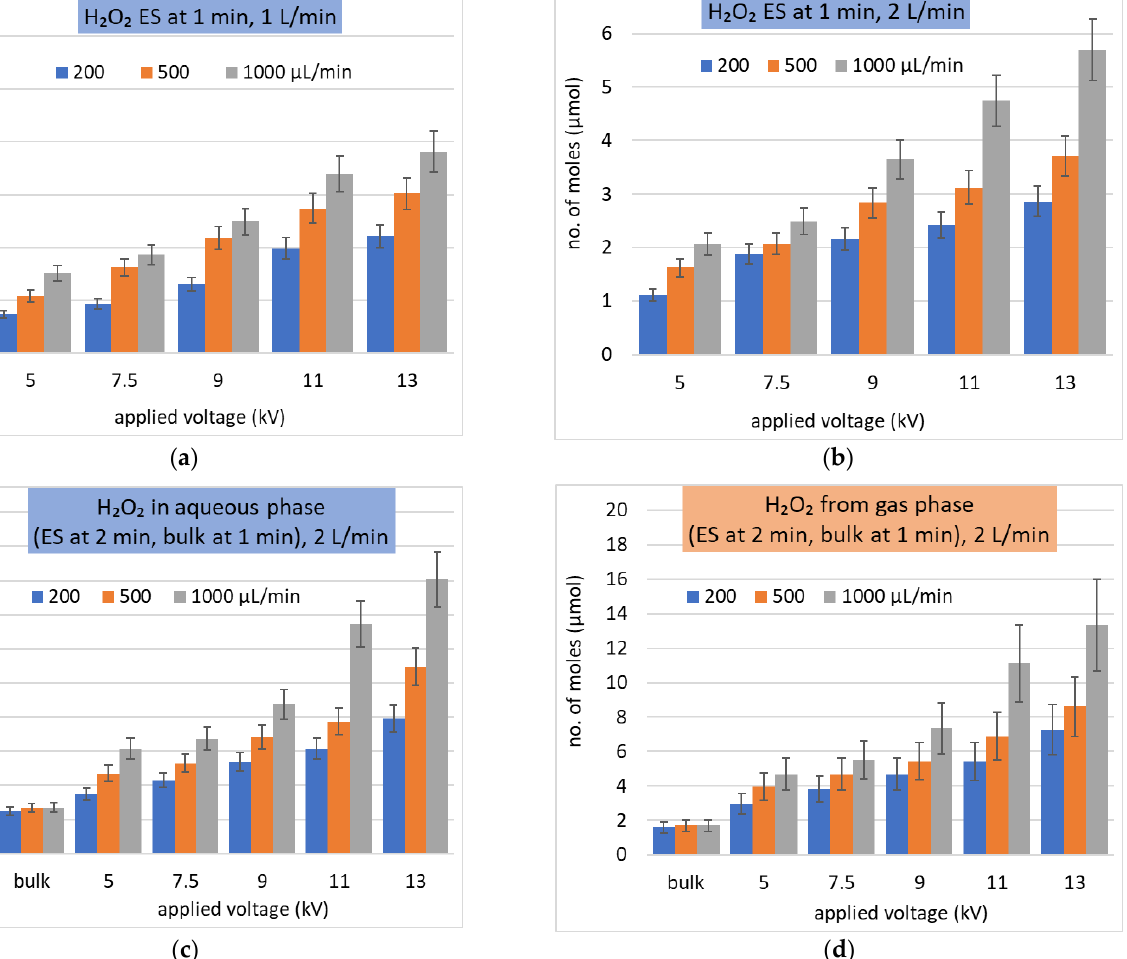
Figure 8. Solvation of H 2 O 2 as the molar number of dissolved molecules in ES. ( a , b ) different gas flow rates (L/min) and Q w (µL/min) during 1 min treatment time; ( b , c ) the same gas flow rate 2 L/min and different treatment times (min) in ES and in ( c ) also bulk water added; ( d ) depleted H 2 O 2 from the gas at the conditions of ( c ).